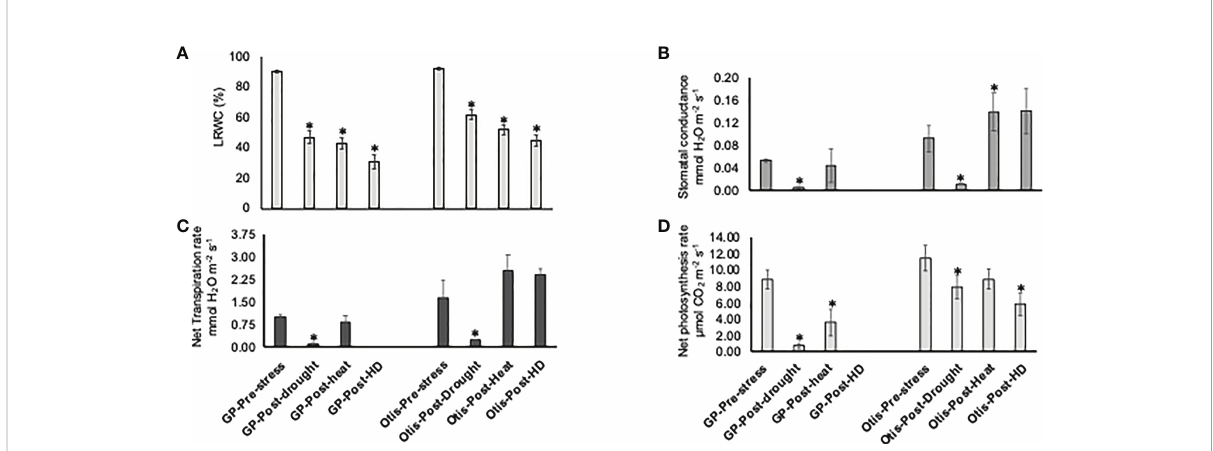
FIGURE 1 Physiological changes in Golden Promise and Otis under heat, drought and combined heat and drought stress (A) Leaf Realtive Water Content (LRWC). (B) Stomatal conductance. (C) Net transpiration rate. (D) Net photosynthetic rate. Values are the means of fi ve plants. Bars represent standard errors of the means. *P <